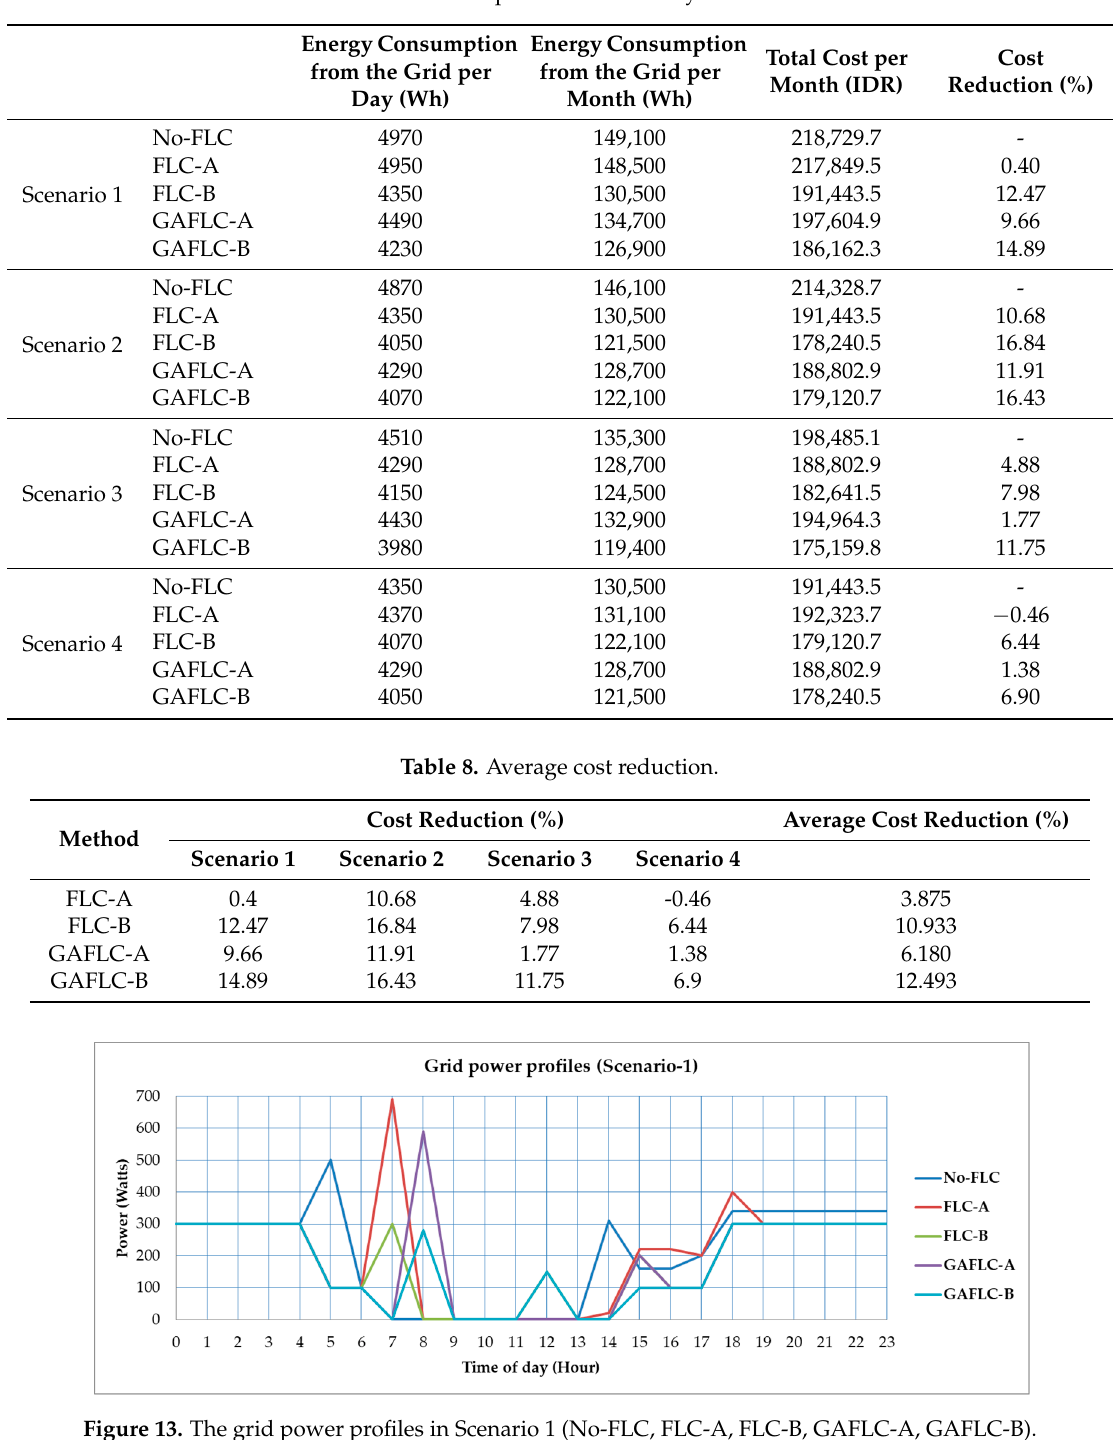
Table 7. Comparison of electricity costs.